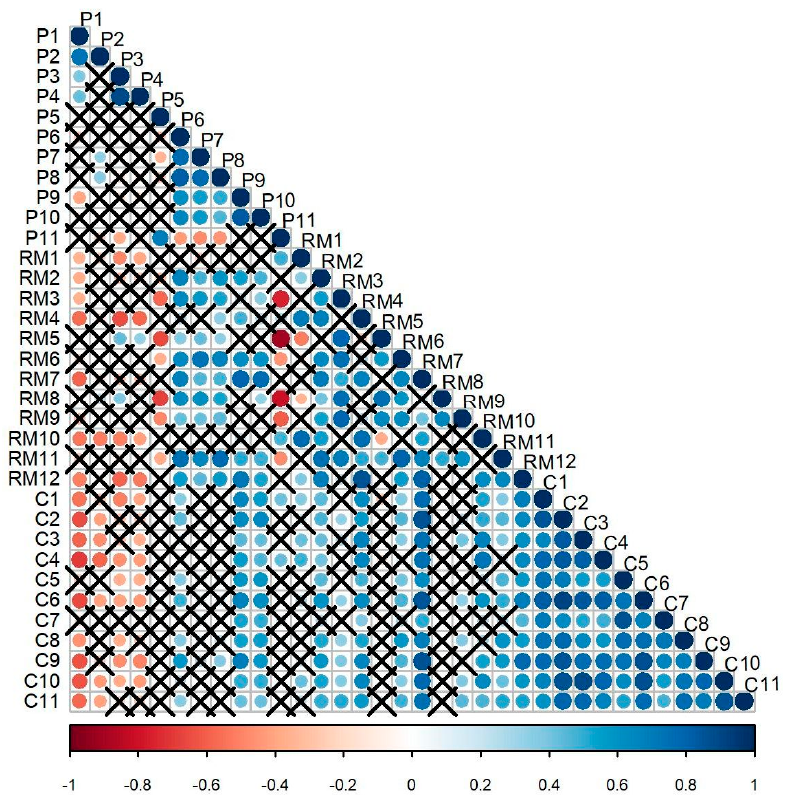
Figure 3. Spearman rank correlation matrix of ecosystem services. Significant positive correlations are marked in blue, significant negative correlations in red, and non-significant or weak correlations are marked as crosses.